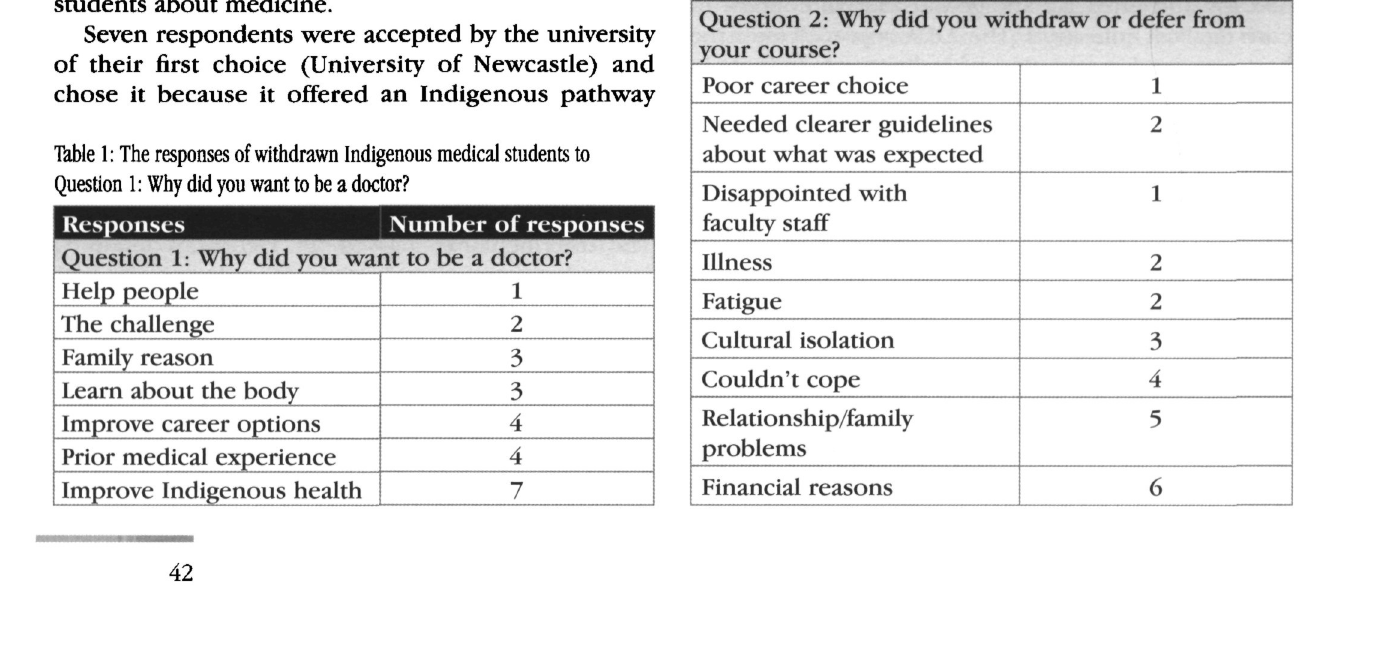
Table 2: The responses of withdrawn Indigenous medical students to Question 2: Why did you withdraw or defer from your